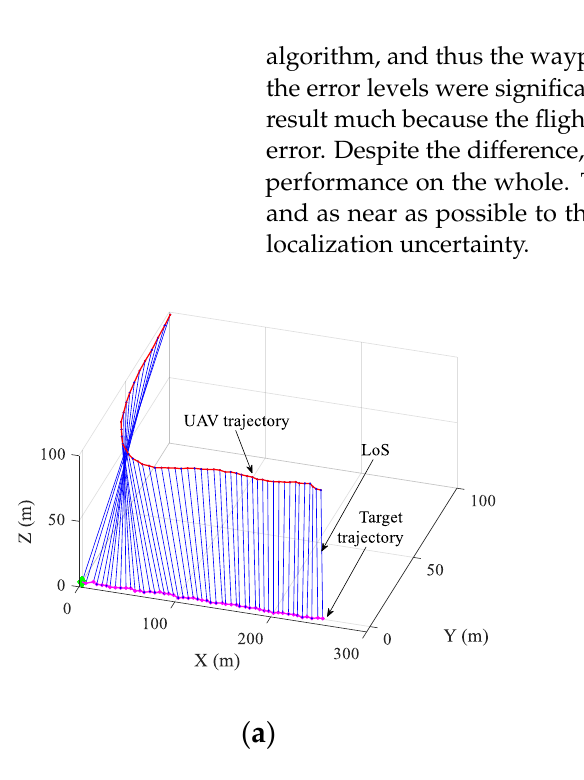
Figure 13. Trajectory optimization results. ( a ) Trajectory with minimum velocity of 0 m/s; ( b ) trajectory with minimum velocity of 5 m/s. Appl. Sci. 2020 , 10 , x FOR PEER REVIEW